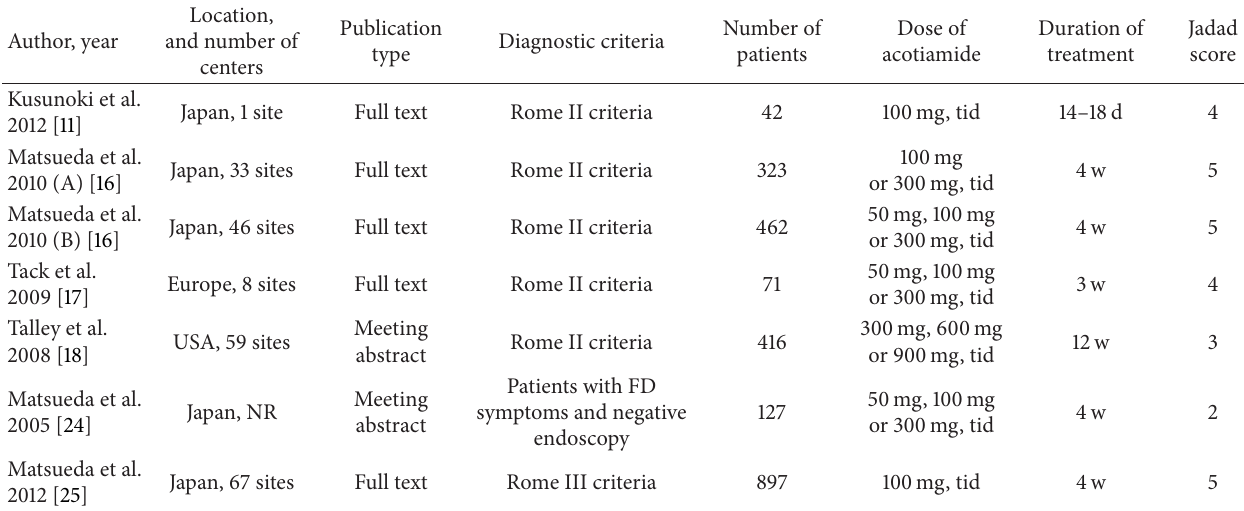
Table 1: Main characteristics of eligible studies.